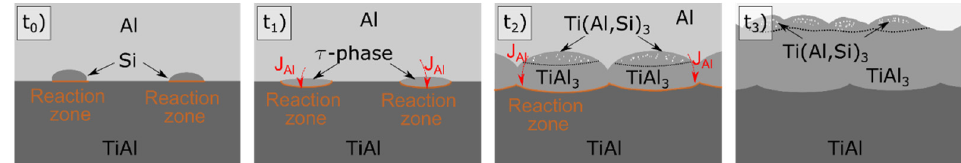
Figure 16. Mechanism for the phase evolution of the Al-1Si coating during heat treatment over time (t 0 < t 1 < t 2 < t 3 ).